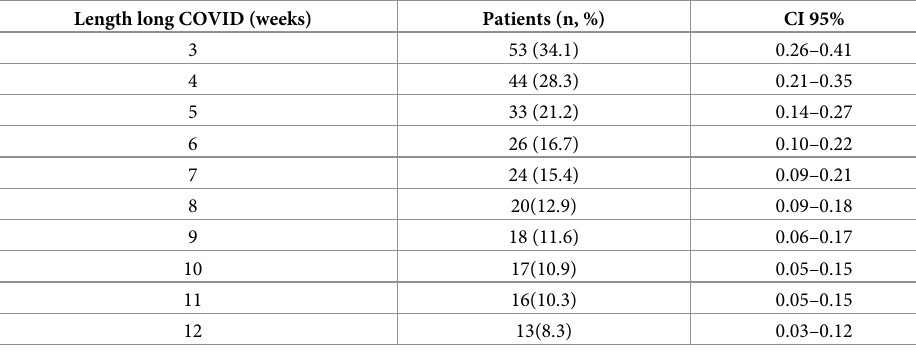
Table 2. Possible cut-off points to define long COVID. Length long COVID